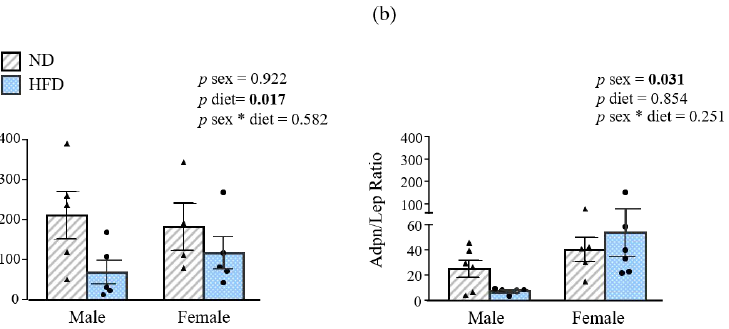
Figure 3. Adiponectin/leptin (Adpn/Lep) ratio of ( a ) 12- and ( b ) 32-week-old mice. Data are presented as the mean ± SEM of 6–8 animals per group. Statistical differences were analyzed by two-way ANOVA. * interaction between both factors (sex and diet); Adpn, adiponectin; HFD, high-fat diet; Lep, leptin; ND, normal diet; p values lower than 0.05 are highlighted with bold text. Focusing on male mice, a negative correlation of the Adpn/Lep ratio with BW ( r = − 0.59, p = 0.005) as well as with different fat depots, including GWAT ( r = −0 .65, p = 0.002),